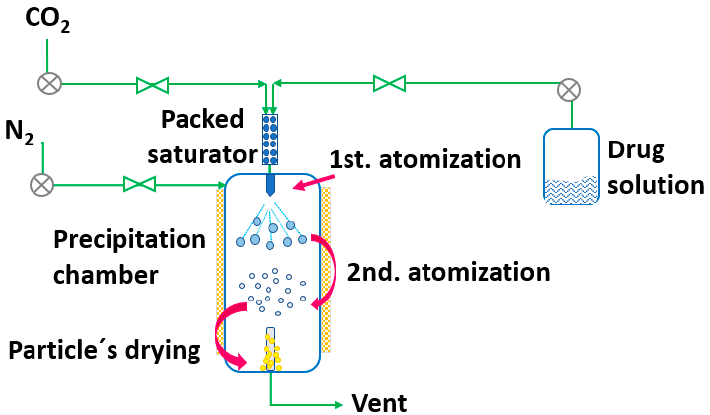
Figure 10. Supercritical Fluid-Assisted Atomization (SAA) process (adapted from Franco et al. [135]).